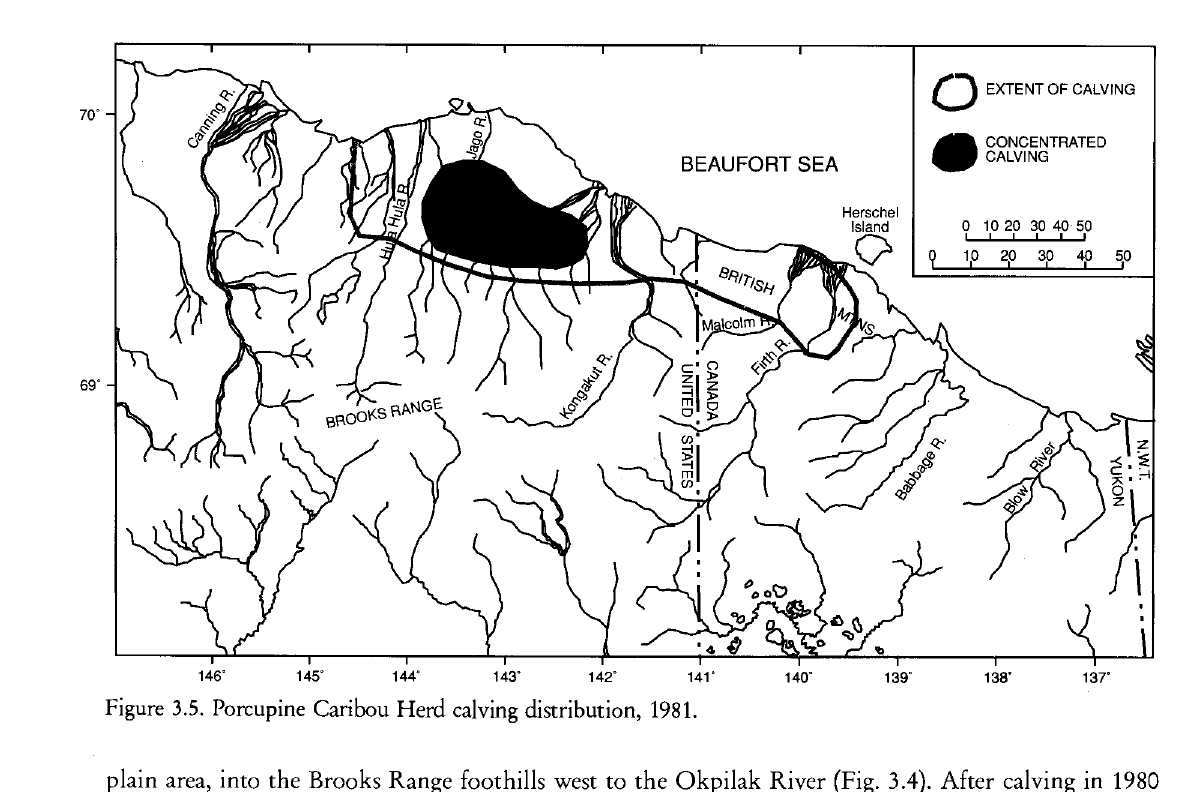
Figure 3.5. Porcupine Caribou Herd calving distribution,